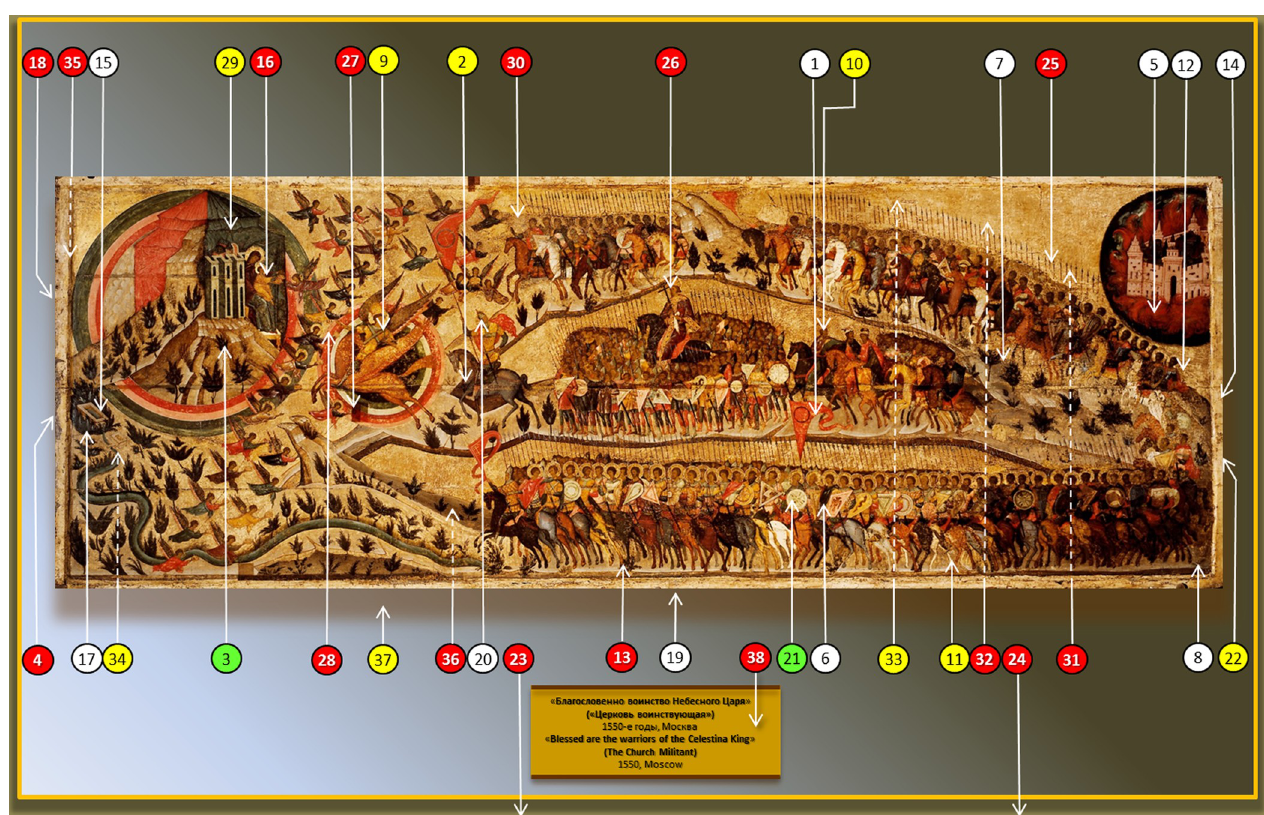
Fig 1. Sampling from icon “The Church Militant” and its surroundings. Arrows with solid lines indicate sampling from the front (tempera) side and arrows with dotted lines–sampling from the rear side. Sample numbers (1–38) are given in circles. Colors indicate growth on different culture media: yellow, growth only on LB, green–only on CD, red–on both LB and CD, and white–no growth on